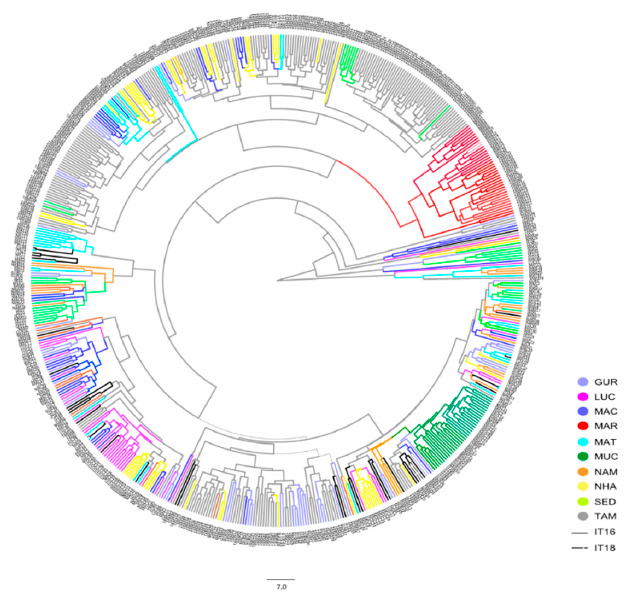
Figure 6. Circular UPGMA tree based on all morphological traits showing the distribution of the 610 cowpea specimens. The different colors indicate the landraces following Table 1. The two cultivars are also indicated.